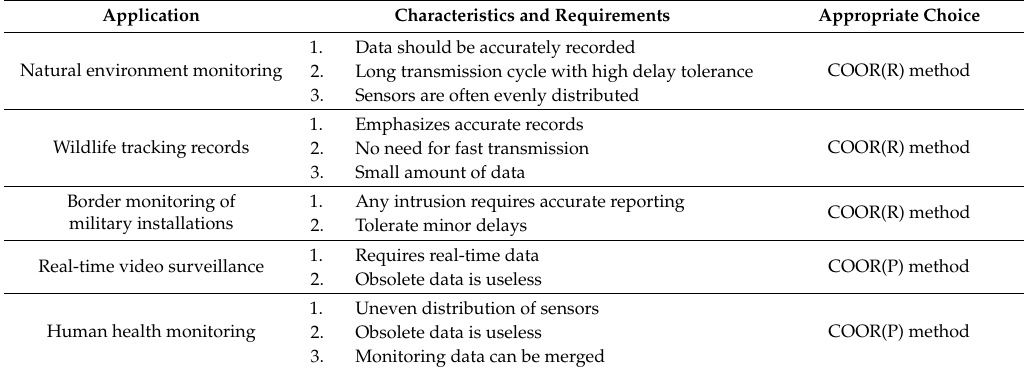
Table 3. Practical applications and method